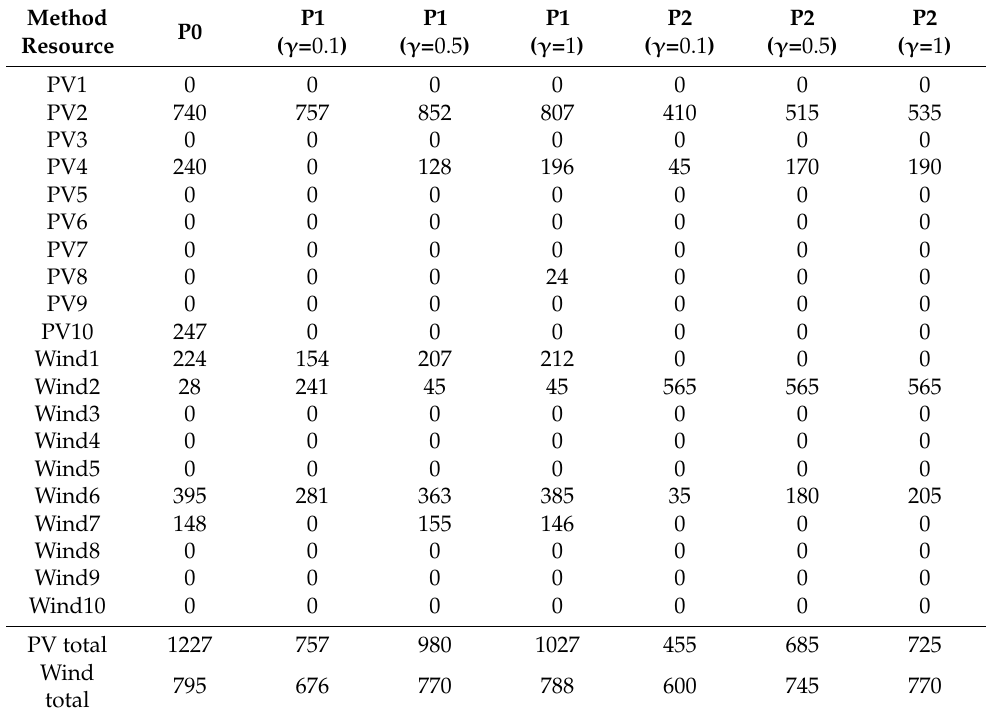
Table 1. VPP implementation results for a commercial SEC.